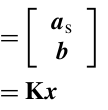
Figure 5. Fraction of background influence for all sites on 13 May at 21:30UTC. Although entries in the BIM are unitless, here they are shown divided by the background time step. These are therefore residence time probability density functions, with the integrals over the graphs each equal to 1.